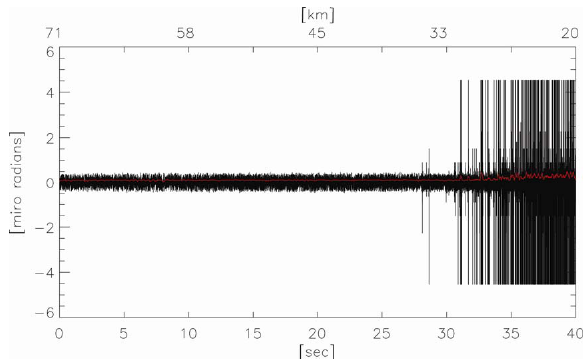
Figure 6 Angular fluctuation of the fine pointing mechanism along the y-direction recorded at OPALE, 07:22:00 UTC was set to 0 in this plot. The red line is the average calculated at 0.1 second Fig. 6. Angular fluctuation of the fine pointing mechanism along intervals of the corrections. the y -direction recorded at OPALE, 07:22:00UTC was set to 0 in The scintillation index is computed as the variance of the flux normalized by the square of the average flux: this plot. The red line is the average calculated at 0.1s intervals of ( the